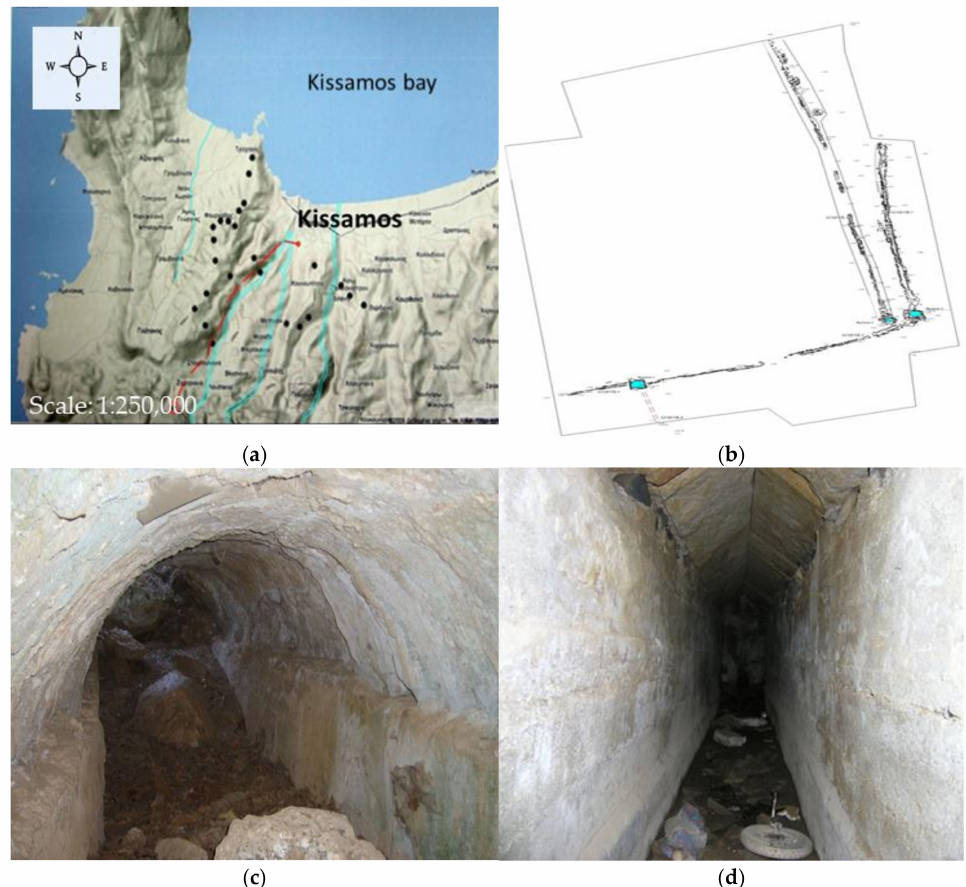
Figure 15. Water supply of Kissamos: ( a ) Hydrogeology map (scale 1:250,000) with registered springs (Emeric Program of the Institute of Mediterranean Studies, (gr. ITE) and Technology and Research Institute, (gr. IM Σ ); ( b ) Water pipes and shafts at Gymnasterion plot; plan: archive of the Eph. of Ant. of Chania ( c ) collection cistern ( caput aquae ), (photo by M. Skordou, archaeologist) and ( d ) Interior of conduit under a room (Photo taken by Y.